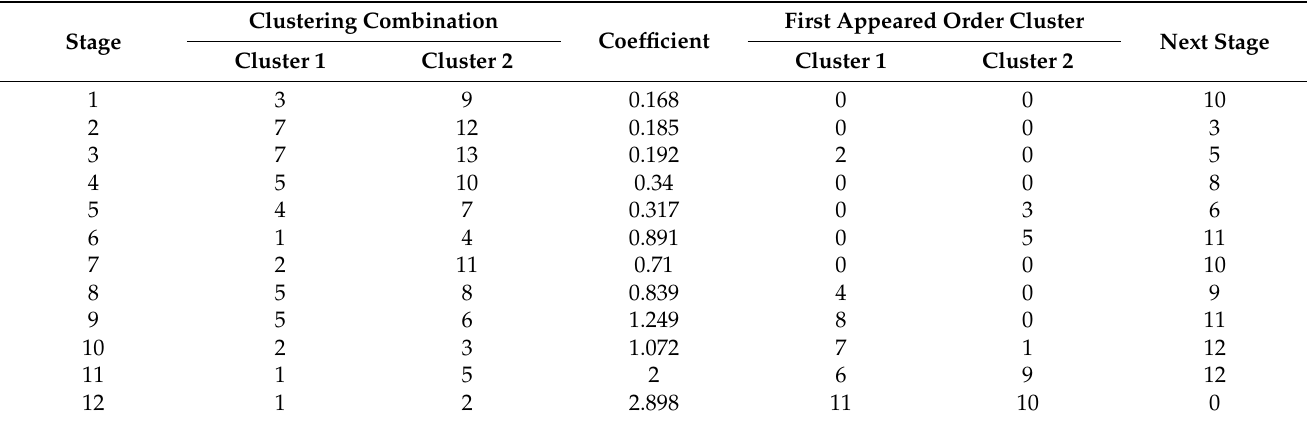
Table 15. Condensation states of TVG